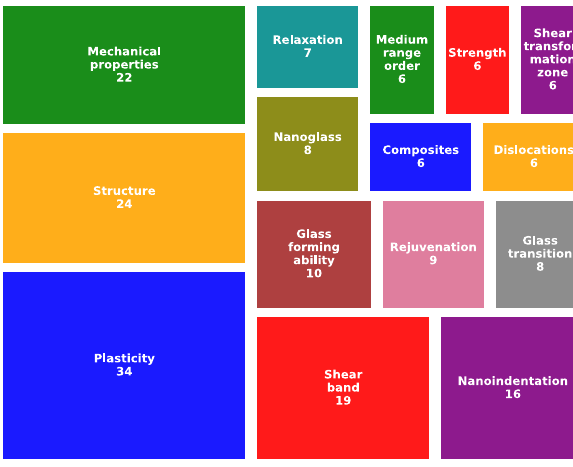
Fig. 9 Most common keywords from 2020 to October 26th, 2021, the date of the literature